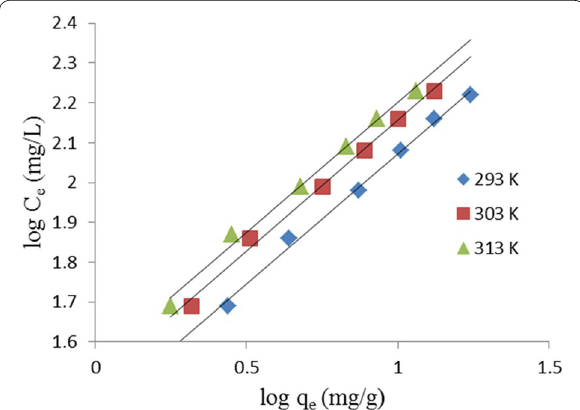
Fig. 5 Linearized Freundlich isotherm plot for removal of MG by TLLP